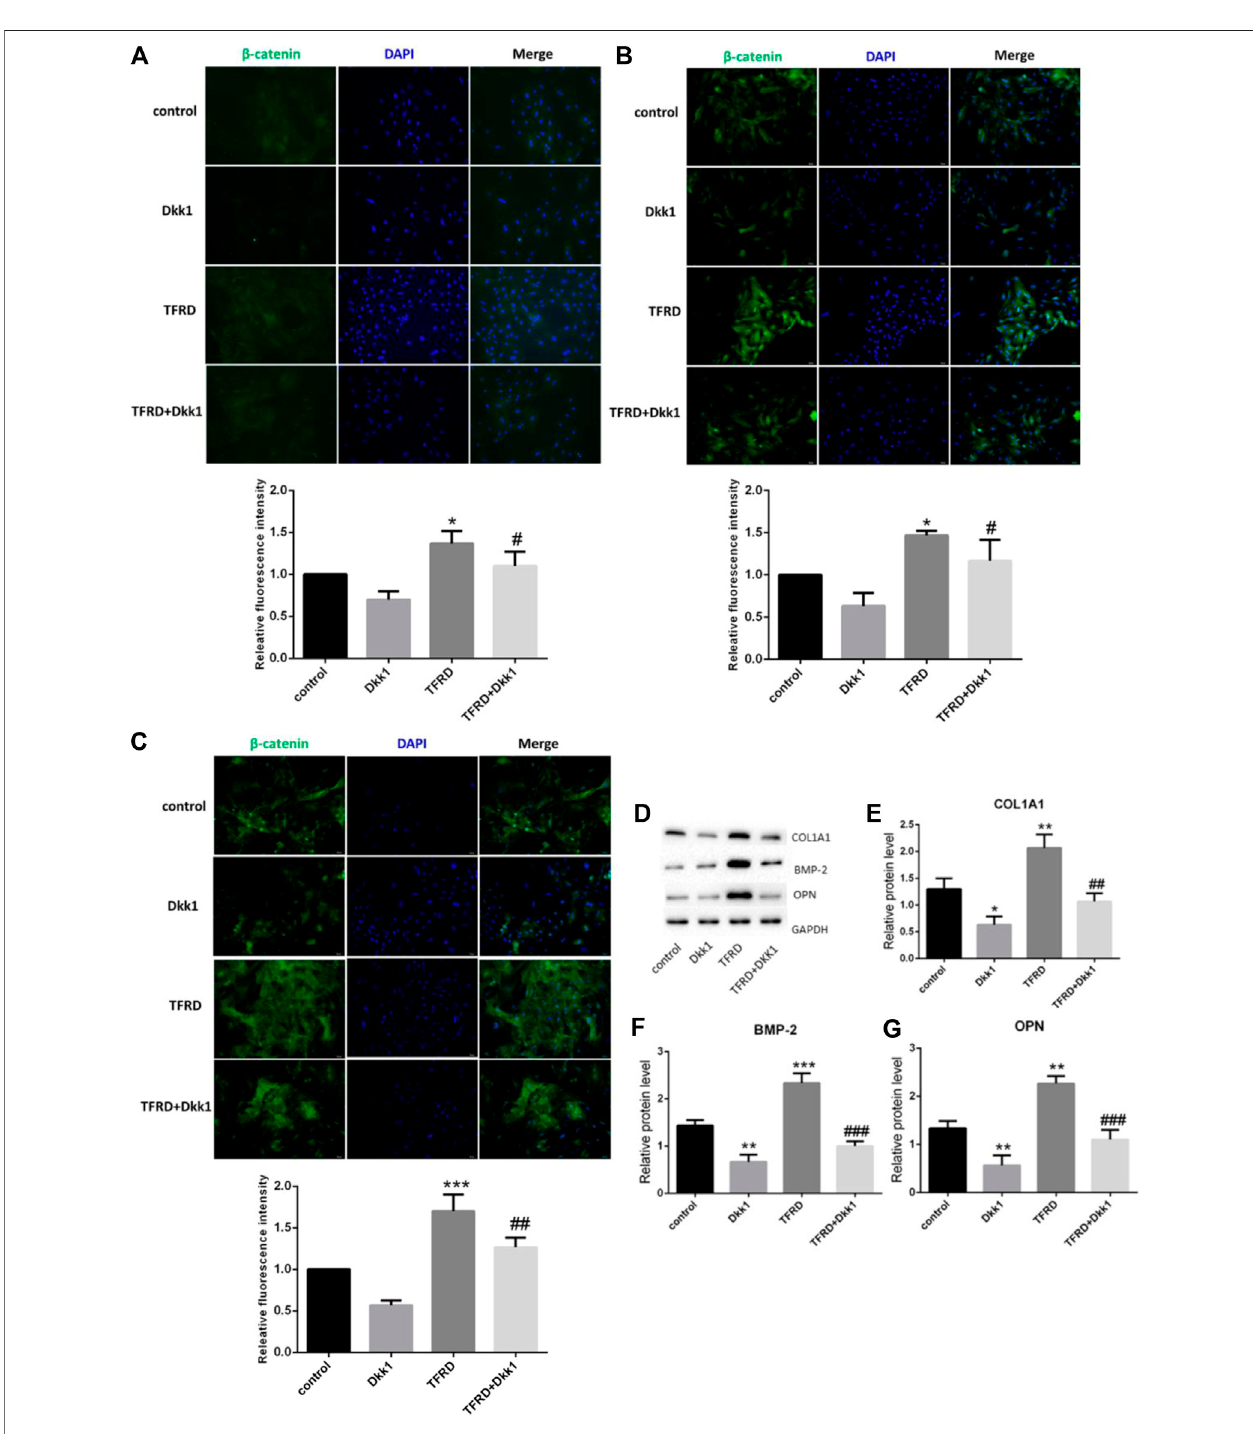
FIGURE6| EffectofTFRDontheexpressionof β -cateninandosteogenic-associatedproteinsinosteoblasts. (A – C) Detectionof β -catenin fl uorescenceindifferent periods (3, 6, 9 days). The β -catenin was positive in cell membrane, cytoplasm and nucleus, showing high-intensity green fl uorescence. Blue fl uorescence indicates the nucleicounterstainedwithDAPI.Valuesarepresentedasthemean ± SDofthreeindependentexperiments. ***p < 0.001, *p < 0.05vs.thecontrolgroup; ## p < 0.01, # p < 0.05vs.theTFRDgroup(magni fi cation, × 200). (D) TherelativeproteinlevelsofCOL1A1,BMP-2andOPNweredetectedbyWesternblot. (E – G) Semiquantitative analysis of protein expression. N (cid:2) 3/group. Each value was presented as the mean ± SD. ***p < 0.001, **p < 0.01, *p < 0.05 vs. the control group; ### p < 0.001, ## p < 0.01 vs. the TFRD